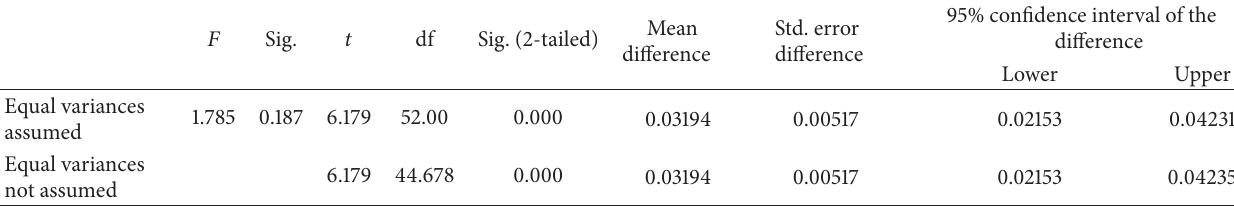
Table 4: Results of the independent samples test.